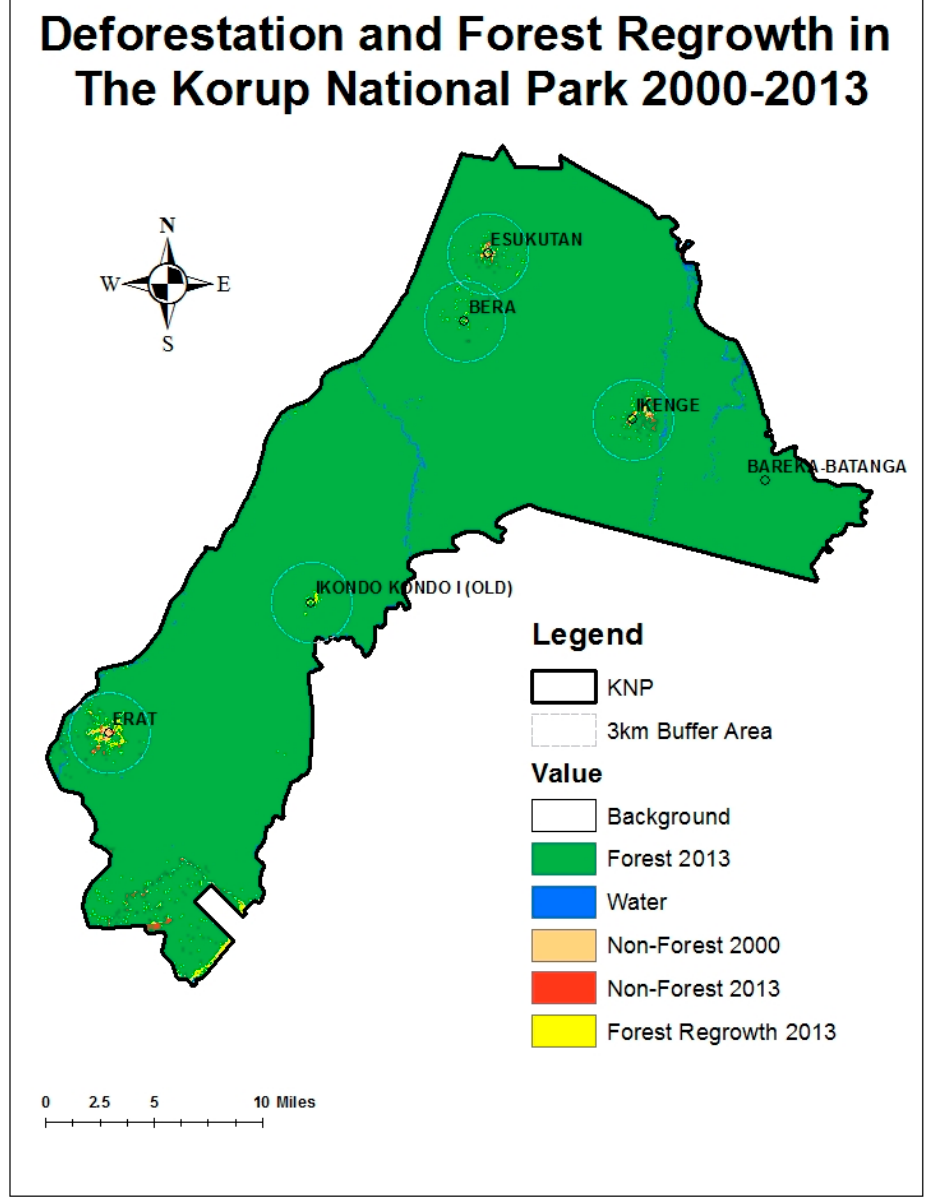
Figure 2. Deforestation and Forest Regrowth in the Korup National Park in Cameroon. Classification by Siewe Siewe. Source: LANDSAT Imagery (USGS Glovis).